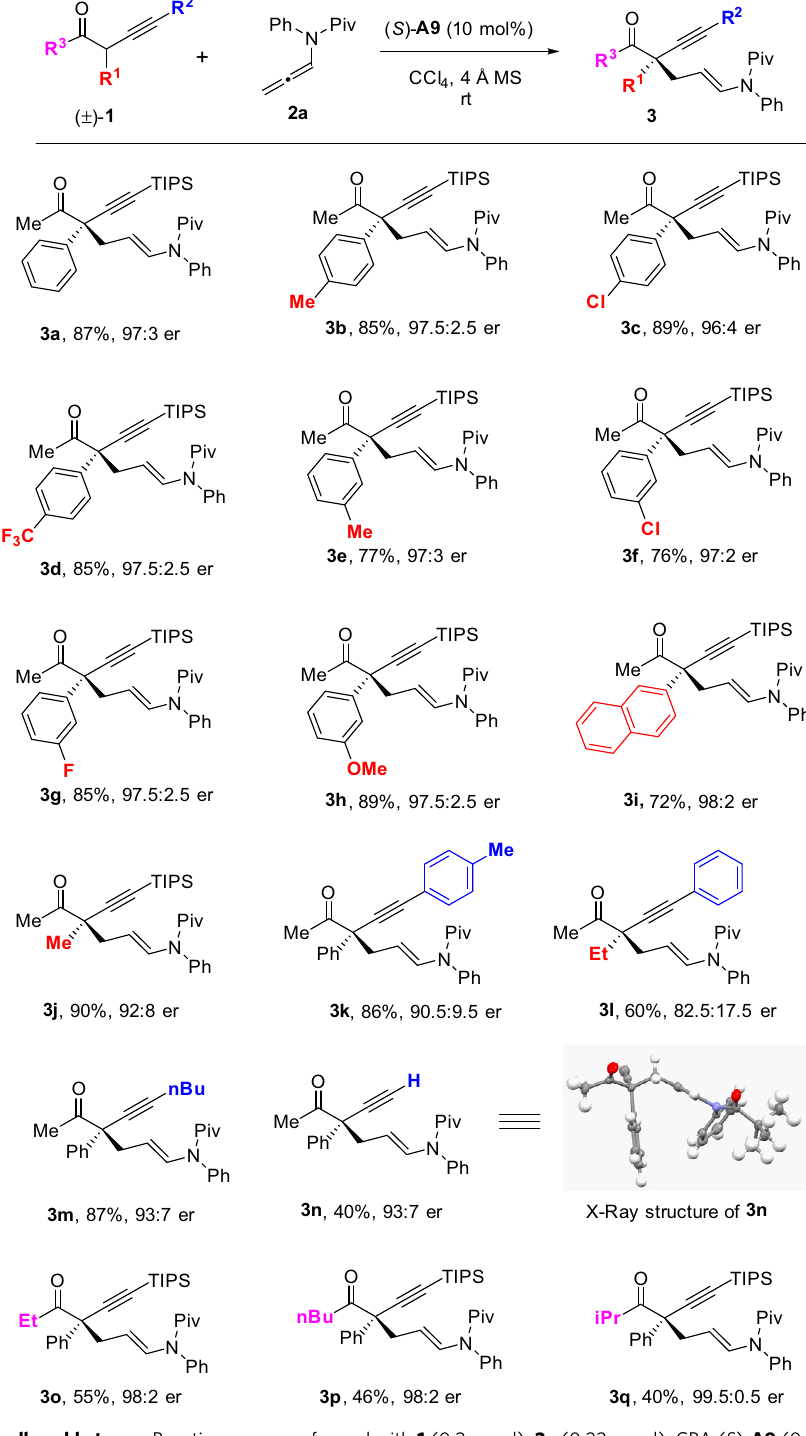
Fig. 2 Substrate scope of α -alkynyl ketones. Reactions were performed with 1 (0.2 mmol), 2a (0.22 mmol), CPA ( S )- A9 (0.02 mmol), activated 4 Å MS (200 mg) in CCl 4 (2 mL) at room temperature. Isolated yields. Er values were determined by HPLC analysis on a chiral stationary